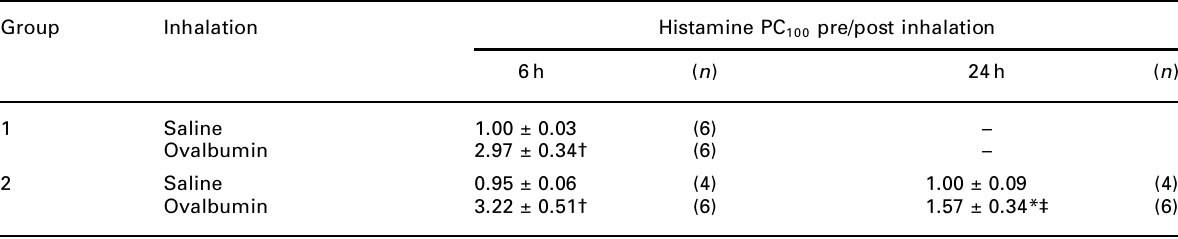
Table 2. Airway reactivity to inhaled histamine of sensitized guinea pigs at 6 and 24h after saline or ovalbumin inhalation